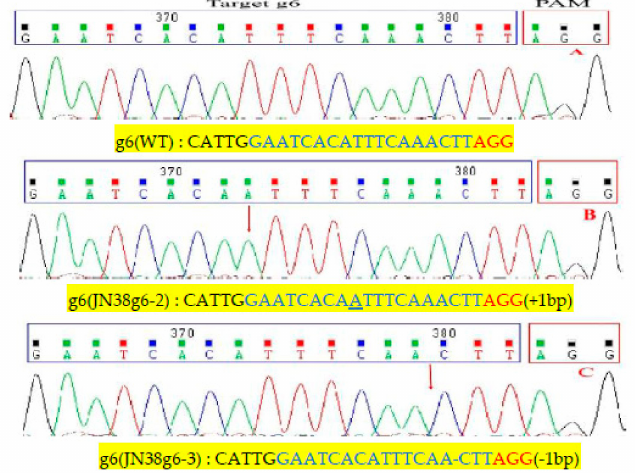
Figure 2. Analyses of sequencing chromatogram data of the target mutant sites of g6. ( A ) Sequences of wild type and representative mutation types induced at target site g6 are presented, respectively. Underline, insertions. Dashes, deletions. ( B , C ) are sequence peaks of wild type and representative mutation types at target site g6 respectively. The red arrowheads indicate the location of